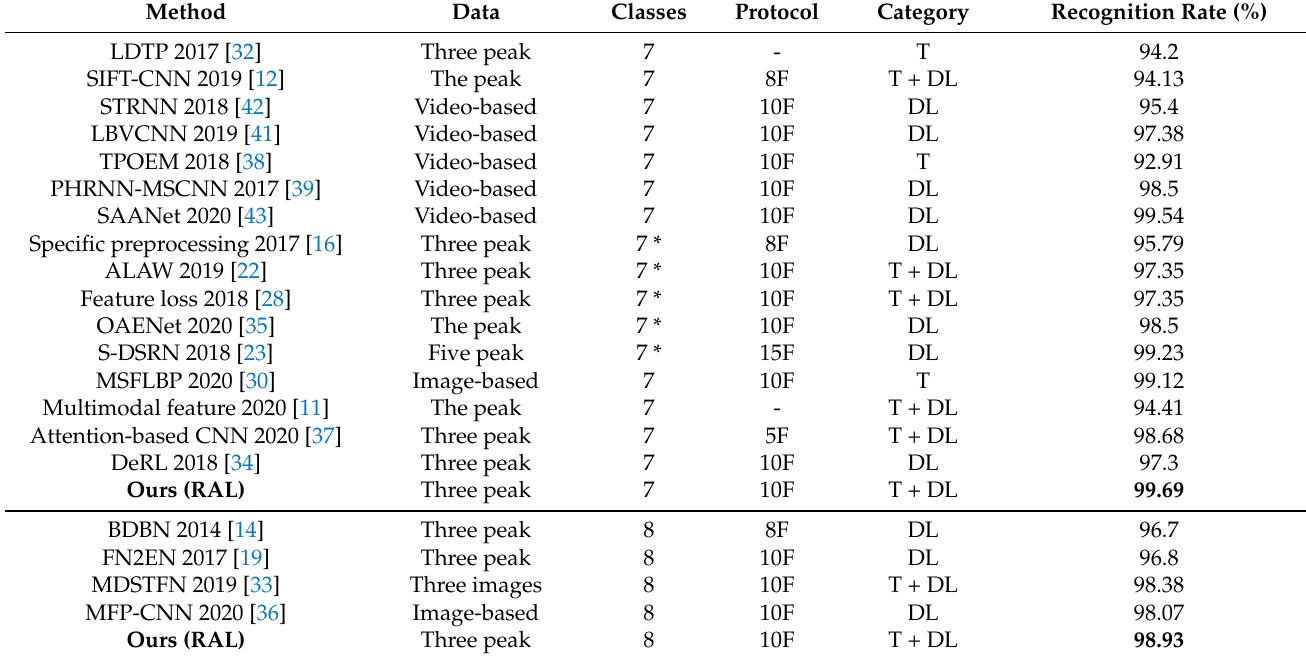
Table 2. Performance comparison with different methods on the CK+. Symbol “-” denotes not reported. Symbol “*” denotes that contempt expression is replaced with neural. “10F” denotes “10-fold cross-validation”. “T” and “DL” denote “Traditional-based” and “Deep-learning-based”,